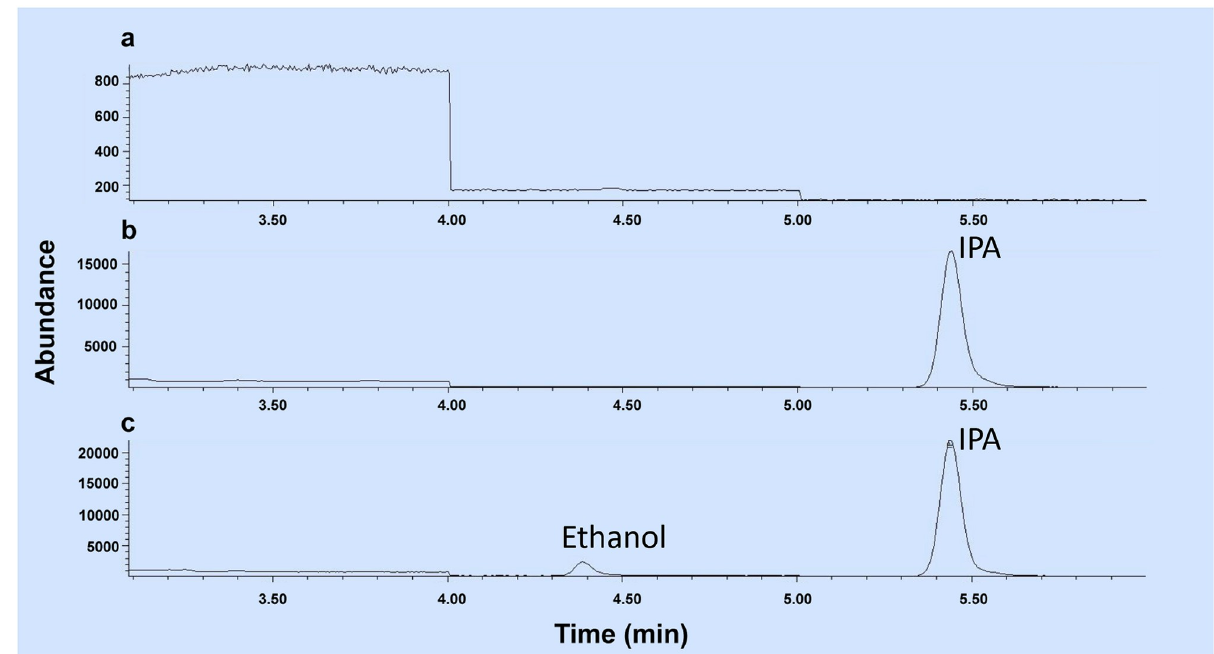
Fig 3. Chromatograms of (a) blank urine, (b) urine sample spiked with 50 ppm IPA, and (c) urine sample spiked with 10 ppm ethanol and 50 ppm IPA.